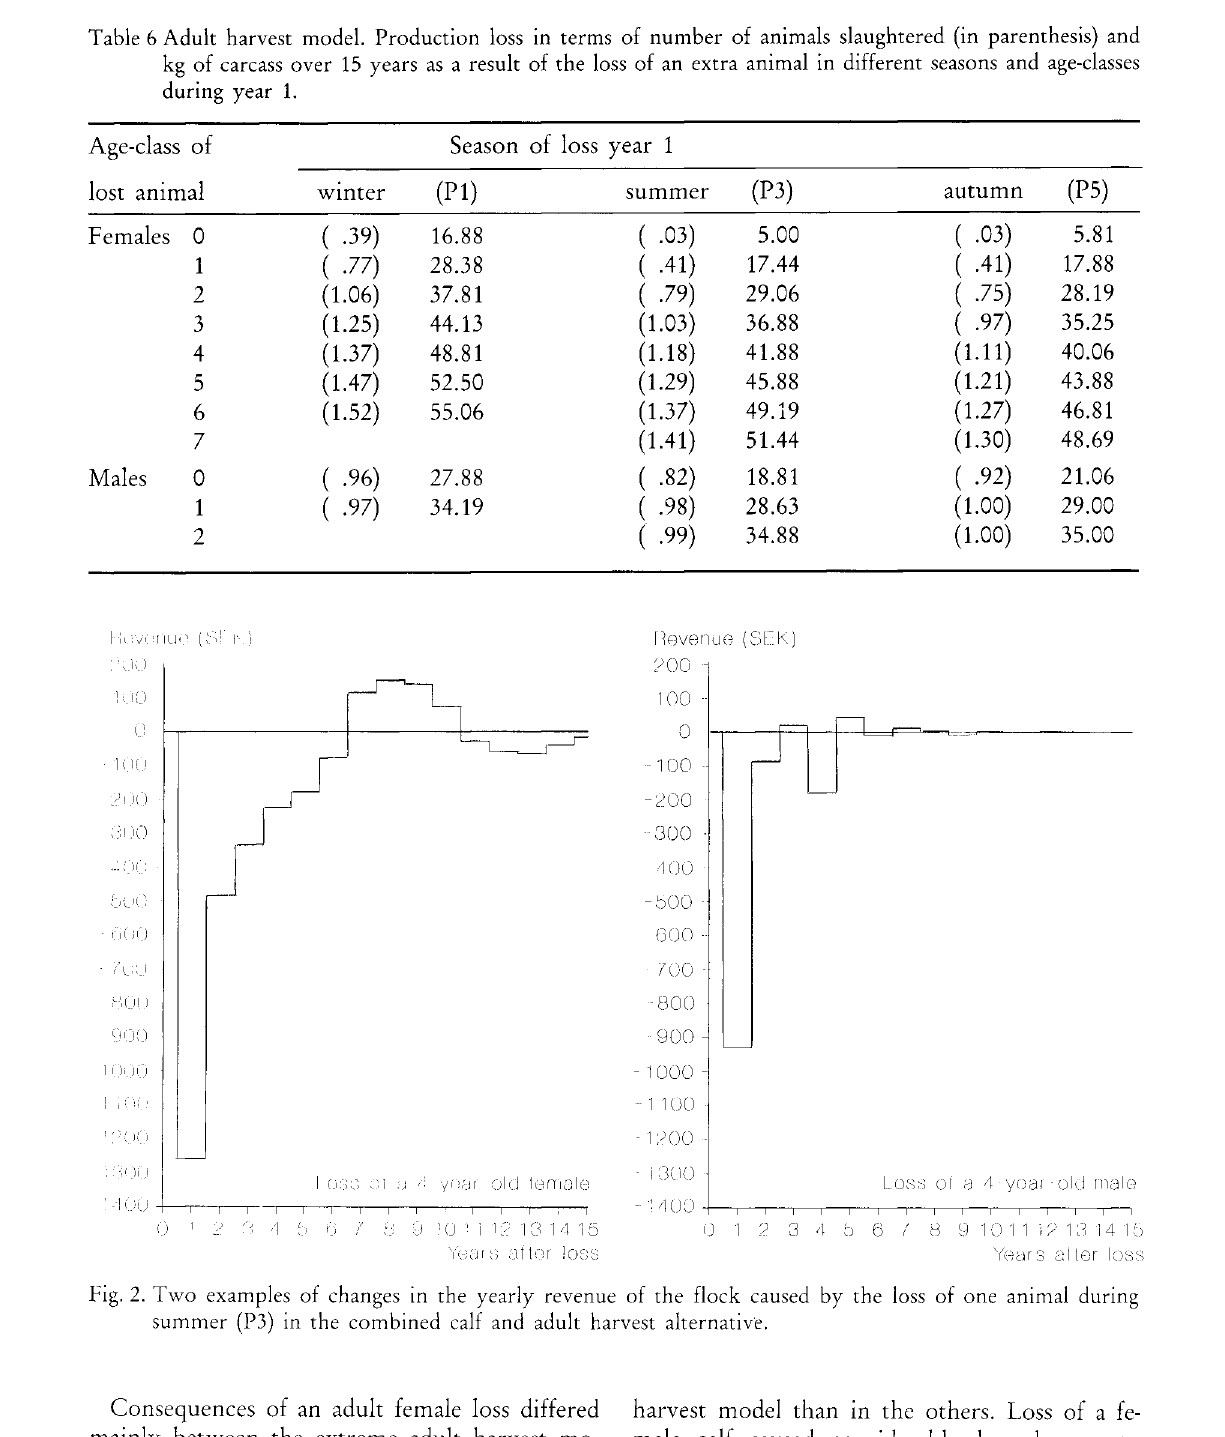
Table 6 Adult harvest model. Production loss in terms of number of animals slaughtered (in parenthesis) and kg of carcass over 15 years as a result of the loss of an extra animal in different seasons and age-classes during year 1.